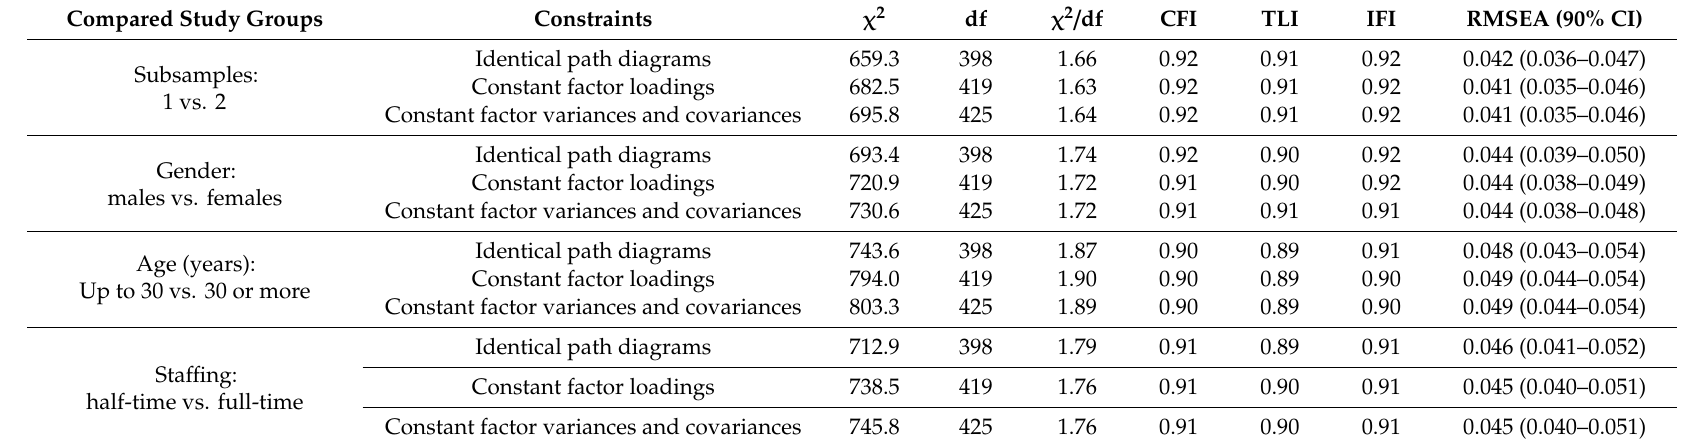
Table 5. Testing the final factor model’s invariance across subsamples, gender, age and sta ffi ng groups ( N = 380). Compared Study